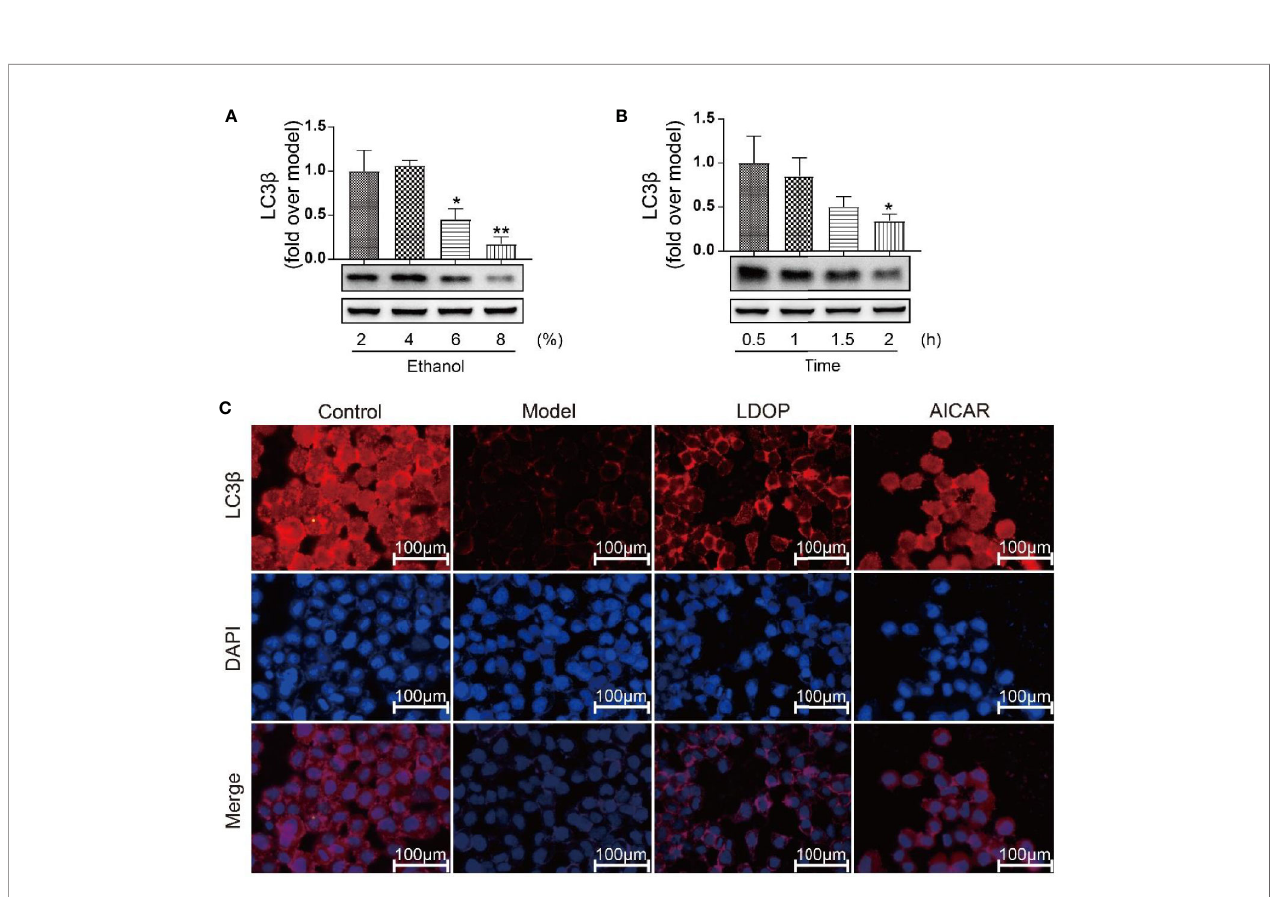
FIGURE 9 | The expression of LC3 b when treated with 2 %, 4 %, 6 %, 8 % concentration ethanol for 0.5 h, 1 h, 1.5 h, 2 h and effects of LDOP-1 on it. (A) The expression of LC3 b at the ethanol at concentrations of 2 %, 4 %, 6 %, 8 %. (B) The expression of LC3 b for 0.5 h, 1 h, 1.5 h. (C) Immuno fl uorescence image of LC3 b measured by immuno fl uorescence technique (GES-1 were treated with 8% ethanol for 2 h after pretreatment with LDOP-1). Data are expressed as the mean ± SD of three independent experiments. *P<0.05 and **P<0.01 compare to 2 % concentrations ethanol or 0.5 h group. LDOP stood for